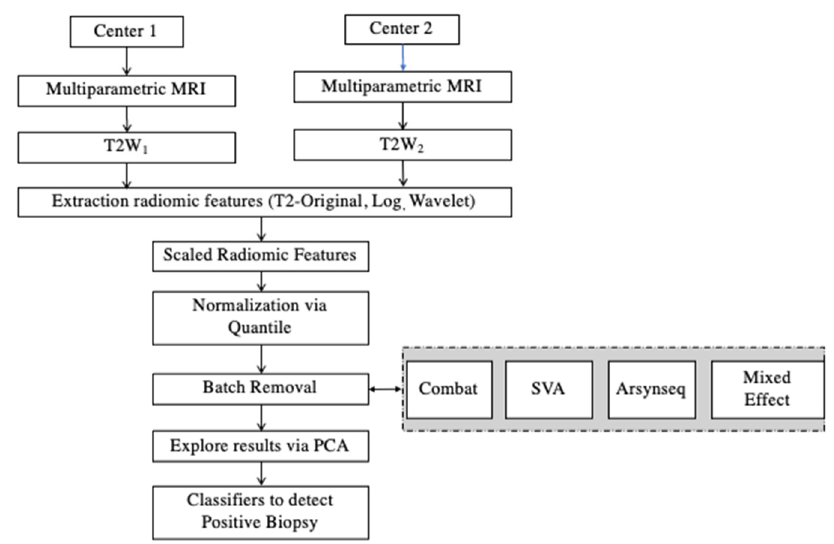
Figure 1. Framework of analysis. MRI: Magnetic Resonance Imaging; PCA: Principal Component Analysis; T2W = T2-weighted; SVA = Surrogate Variable Analysis.